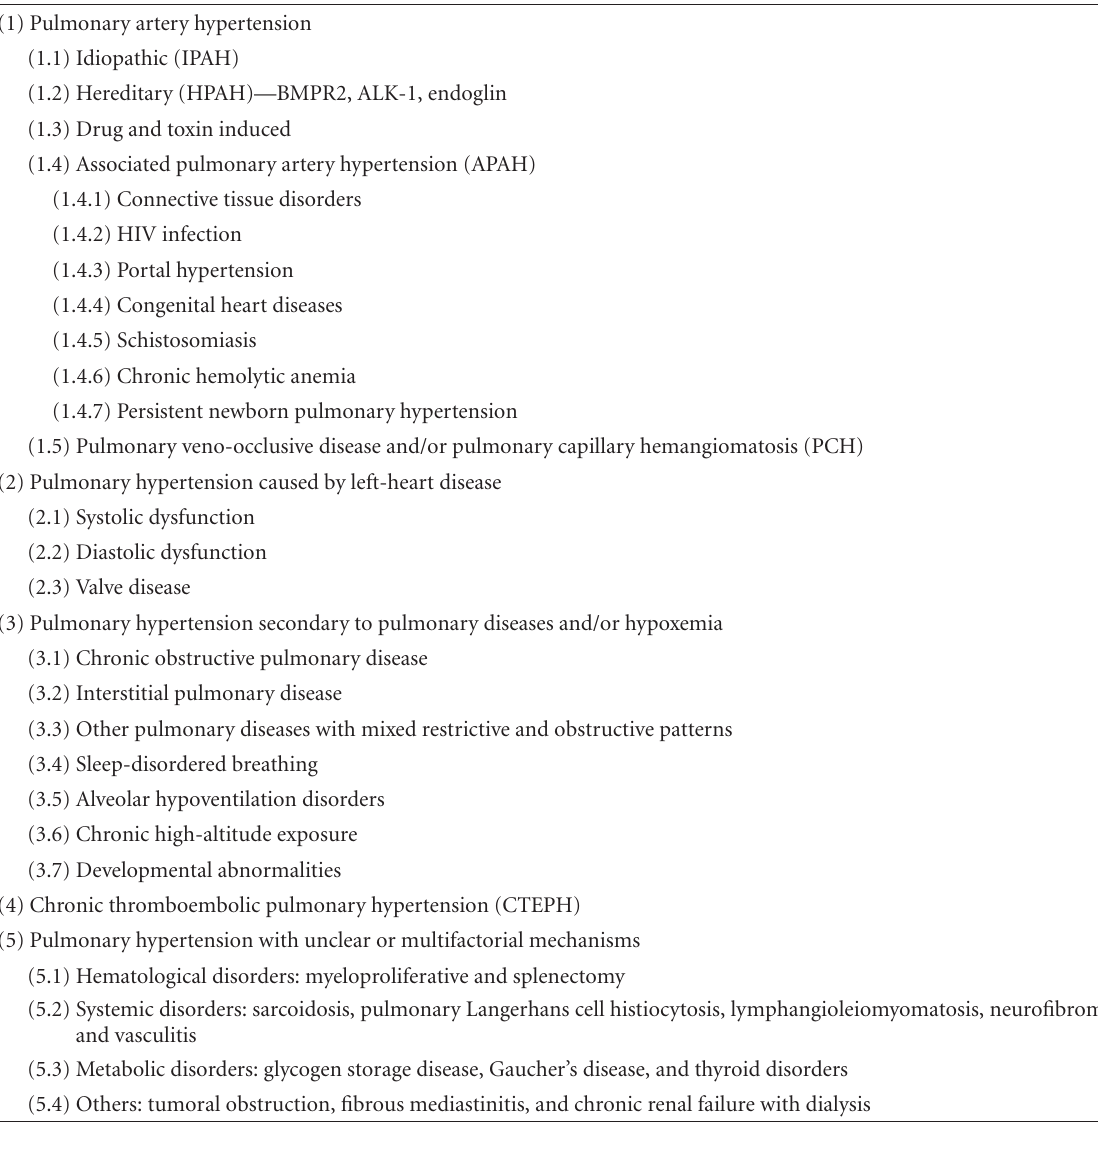
Table 1: Classification of pulmonary hypertension (Dana-point